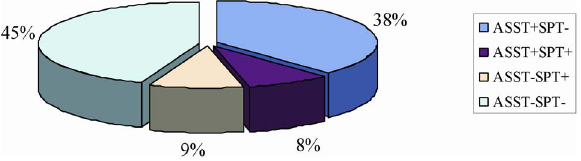
Figure 2. Distribution of subtype of chronic spontaneous urticaria based on the result of ASST and SPT in present study.